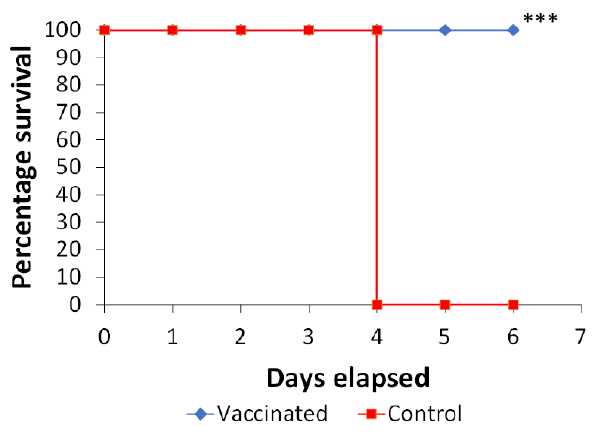
Figure 6. Following PA infection of artificial ulcers, a Kaplan – Meier survival curve was created. Artificial ulcers of PAGs orally immunized diabetic rats were infected with PA and animal survival was observed for 6 days. (***) p < 0.001 by Log-rank (Mantel – Cox) and Gehan – Breslow – Wilcoxon tests.